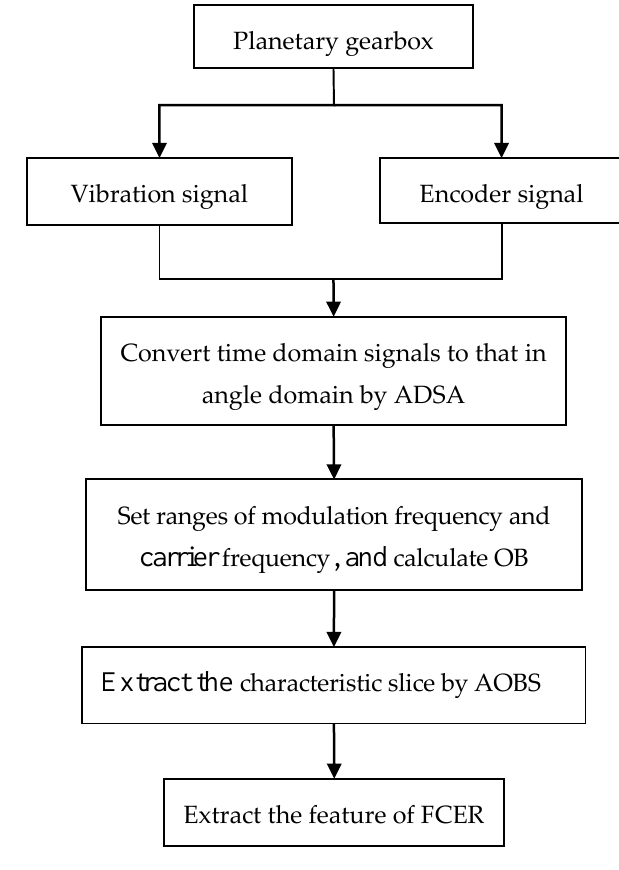
Figure 5. Flowchart of the proposed AOBS-FCER method.